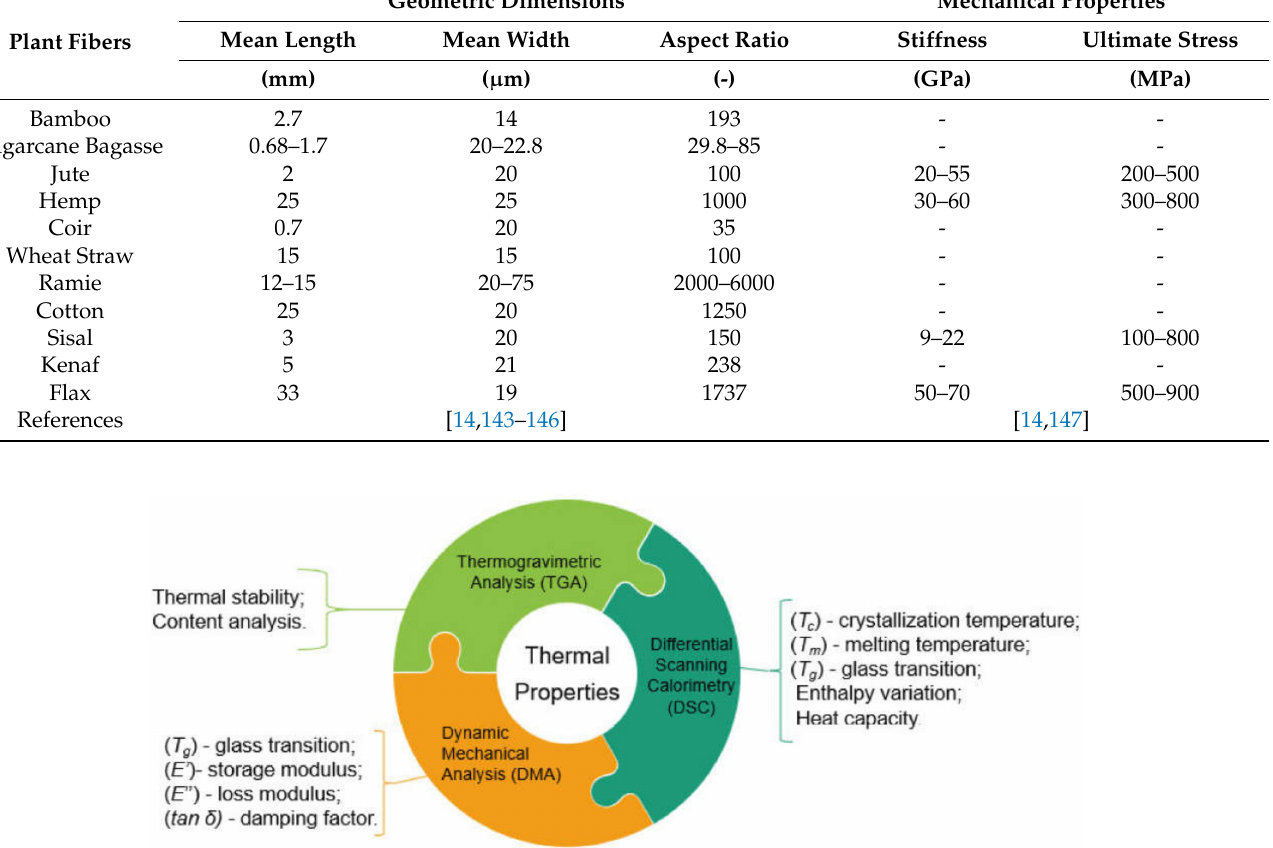
Figure 11. Summary of plant fibers’ thermal evaluation methods [139].